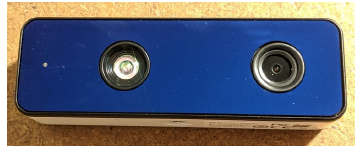
Figure 1. Pico Zense